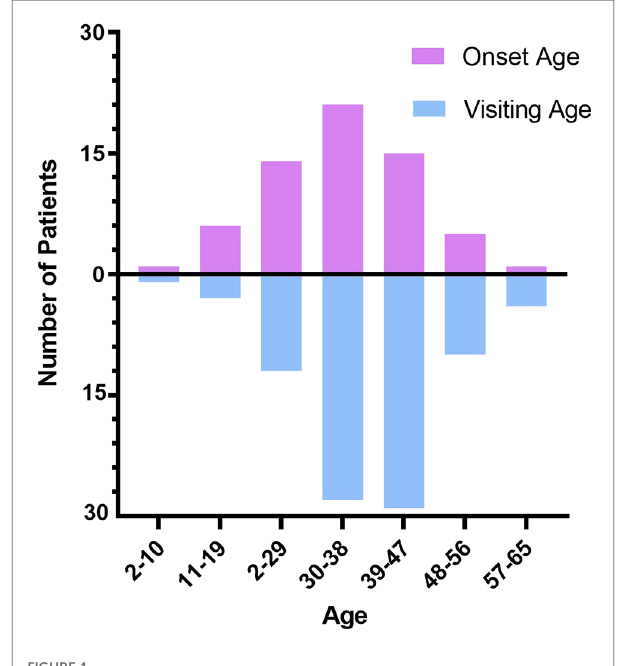
FIGURE 1 Age distribution of